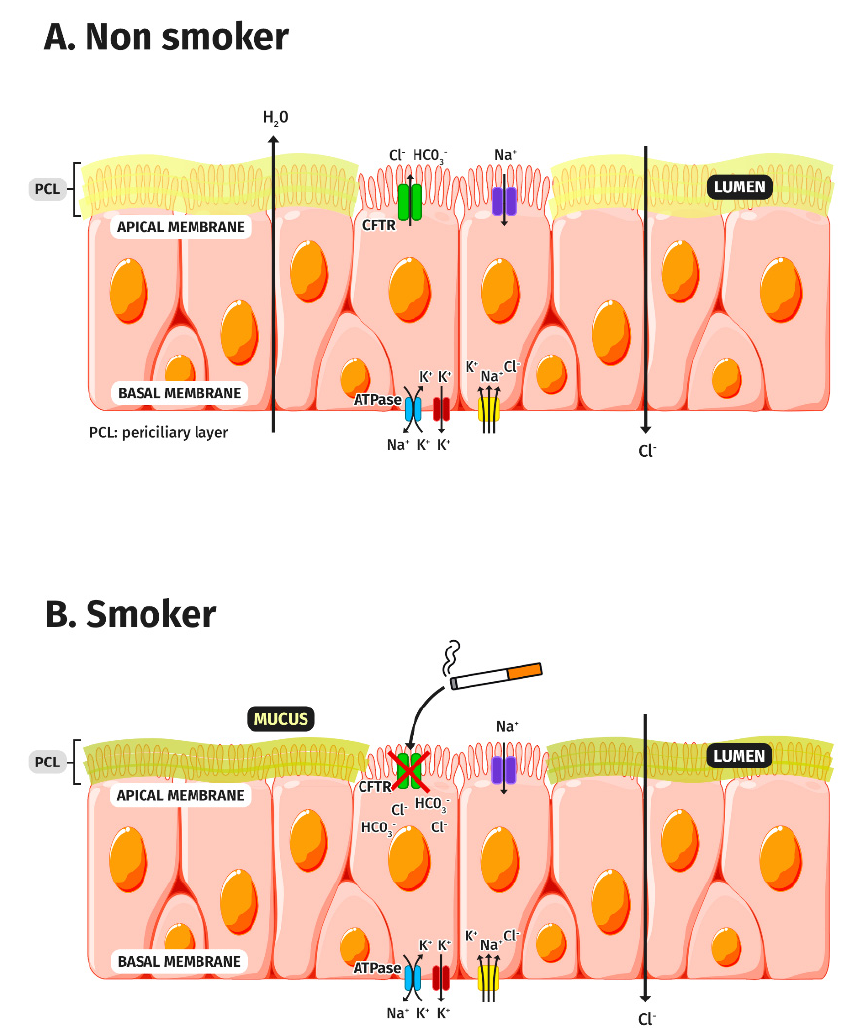
Figure 1. Model of airway surface dehydration in COPD due to CFTR dysfunction. ( A ) In non- smokers, an adequate exchange of ions occurs due to the correct functioning of the CFTR protein, located in the apical membrane of the respiratory epithelium. ( B ) In smokers, cigarette smoke produces a dysfunction of the CFTR protein producing an alteration of ion transport, making the mucus dehydrated, reducing the periciliary layer, and therefore hindering the expulsion of